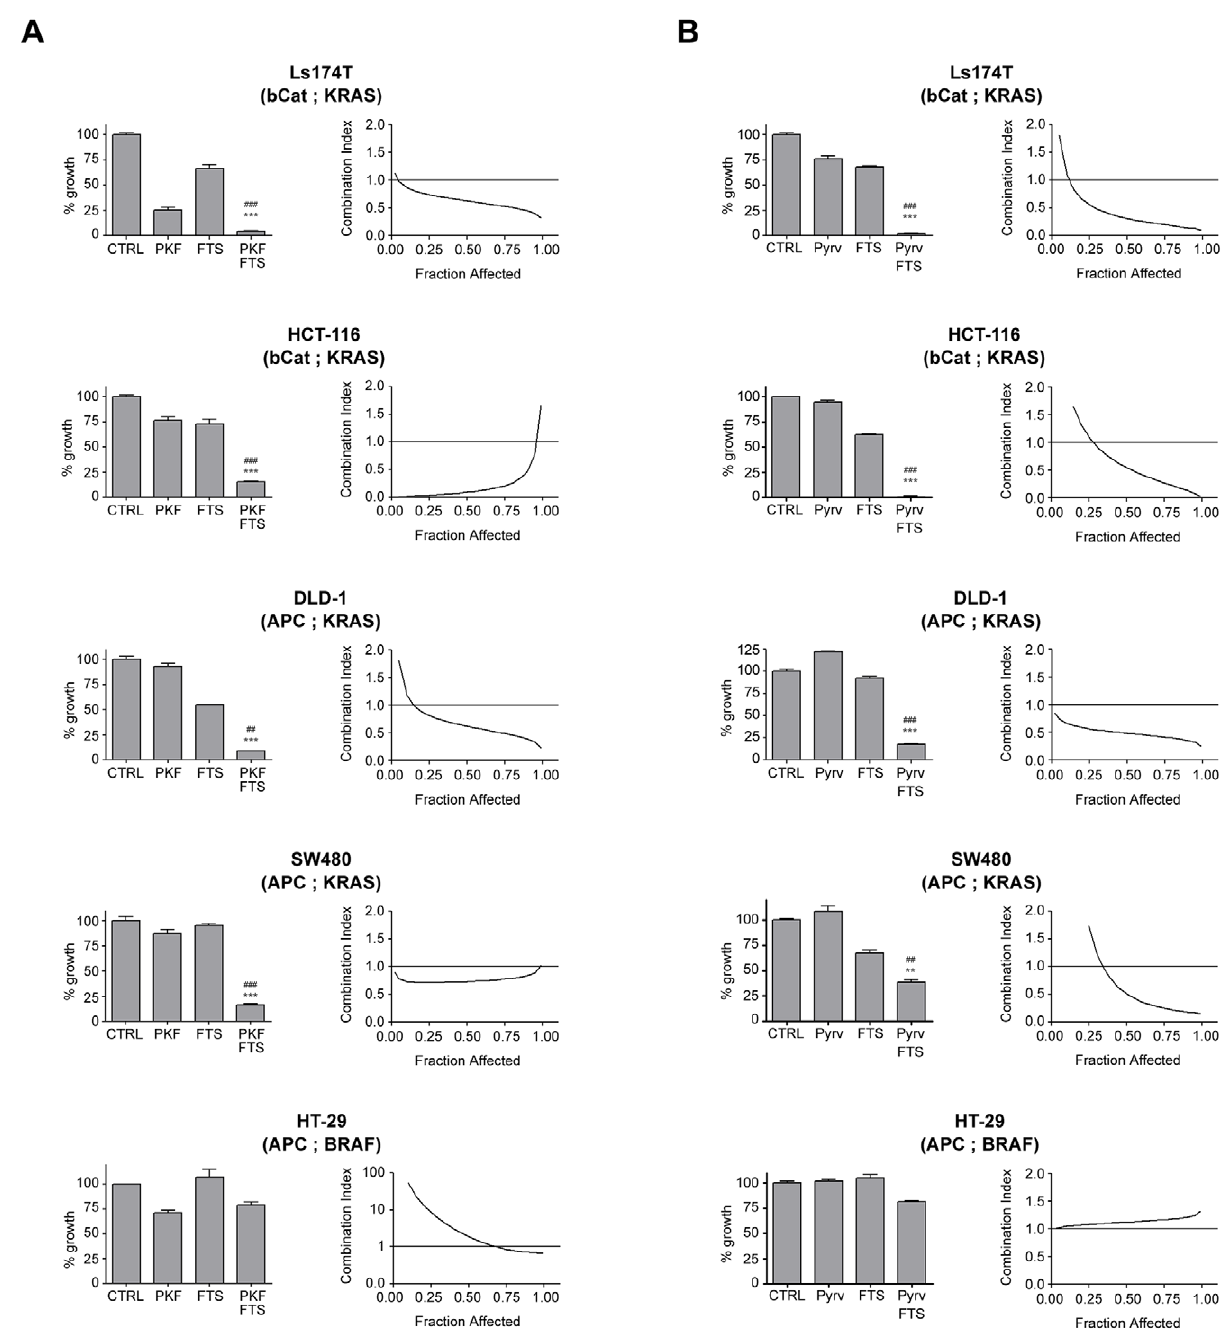
Figure 2. Synergistic effects of PKF115-584/FTS and pyrvinium/FTS combinations on CRC cells. The indicated cell lines were cultured for 6 days in the presence of inhibitors as single agents or in combination, or vehicle alone. MTS assay was used to assess the effects of each treatment on cell culture growth and viability. ( A ) PKF115-584/FTS and ( B ) pyrvinium/FTS combination. For each cell line, the bar graph ( left ) shows the effect at a single dose (PKF115-584, 0.25 m M [Ls174T and DLD-1] or 0.125 m M [SW480 and HCT-116]; pyrvinium, 50 nM; FTS, 100 m M). The XY graph ( right ) shows combination indexes as a function of the fraction affected (see Materials and Methods). For each cell line, the genes that are mutated, affecting Wnt and Ras pathways, are indicated in brackets. CTRL = control; Pyrv = pyrvinium. In all panels, number symbols ( # ) indicate significance versus the b -catenin inhibitor (PKF115-584 or pyrvinium); asterisks (*) indicates significance versus FTS; one symbol, p , 0.05; two symbols, p , 0.01; three symbols p , 0.001. therapy [60,61]. Other genes (RPS6KB1, COX2, CTBP2) showed acting as the receptor for hyaluronan, a major component of the variable regulation among the different cell lines, suggesting cell tumor extracellular matrix. CD44 transcript variants have been line-specific responses. Furthermore, despite many similarities, the shown to be overexpressed and to mediate cell survival in colon two combinations showed some differences in gene regulation. In cancer. Hence, CD44 has been proposed as a target for CRC